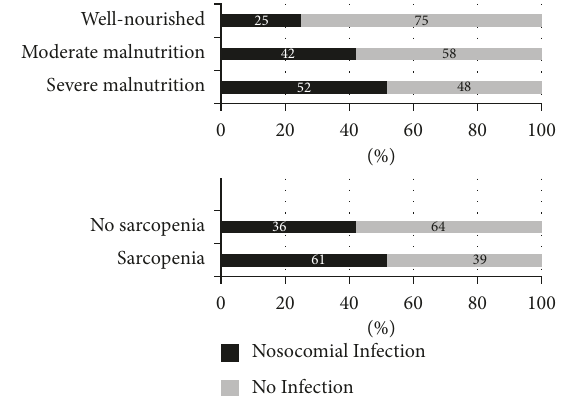
Figure 3: Percentage of nosocomial infection by a diagnosis of malnutrition or sarcopenia in cancer